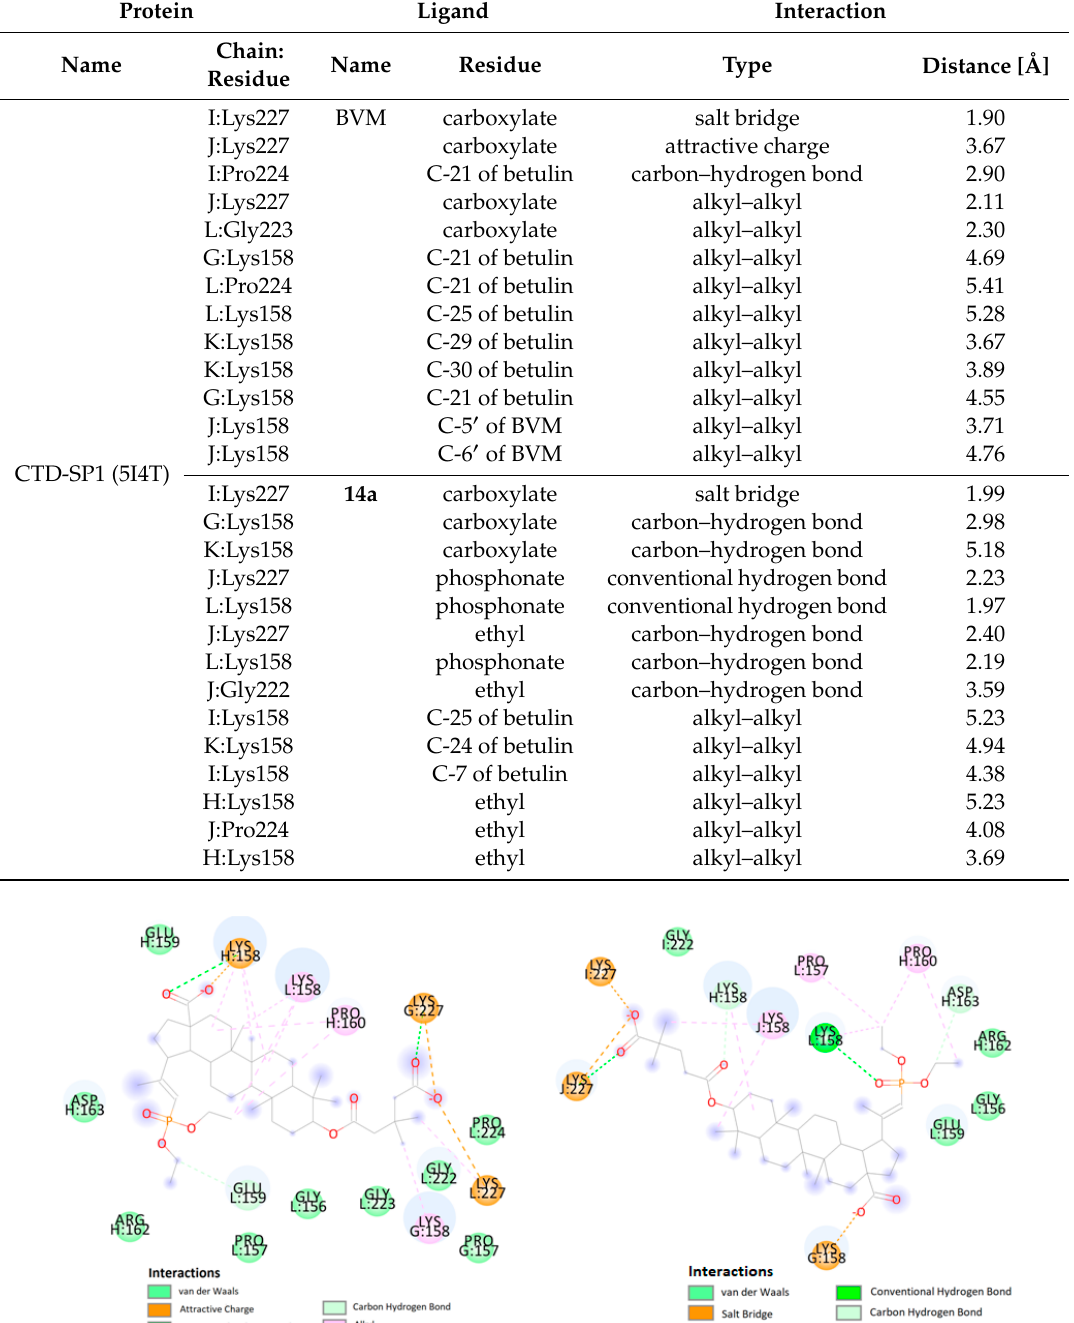
Table 4. Interactions between BVM, 14a , and HIV-1 CA CTD-SP1 protein.